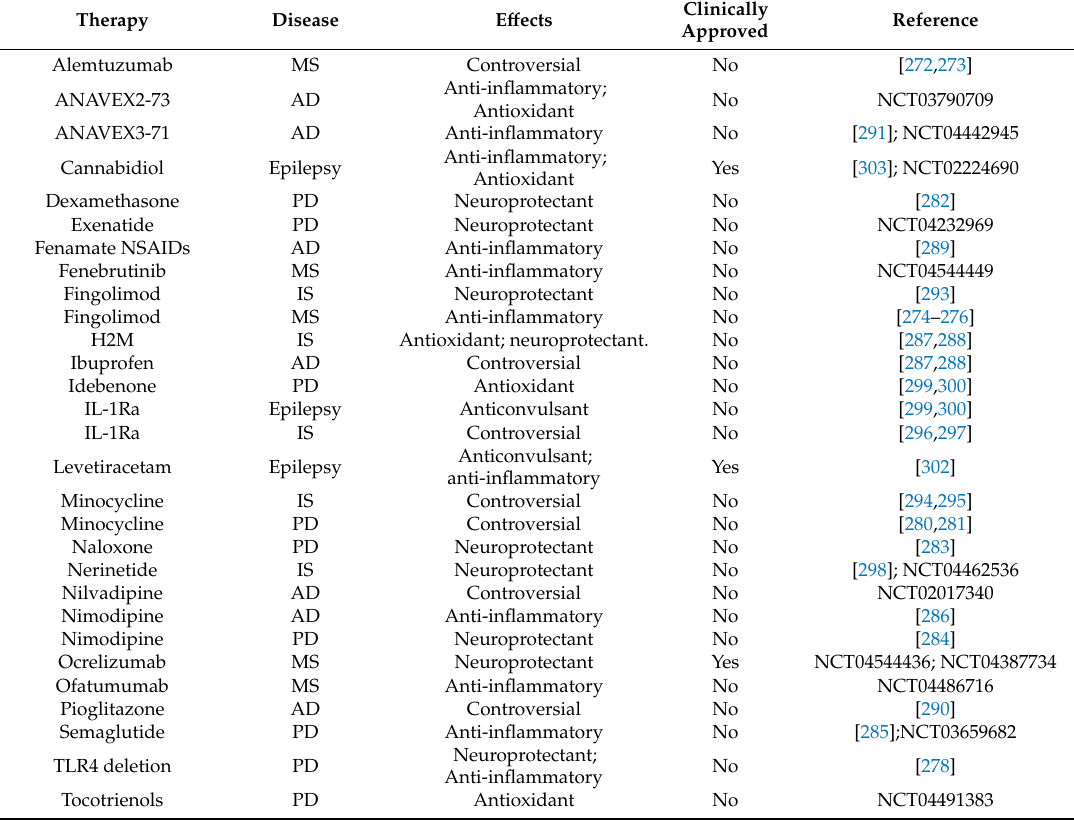
Table 1. List of recent studies and drug therapies targeting neuroinflammation in Parkinson’s disease, Alzheimer’s disease, multiple sclerosis, ischemic stroke, and epilepsy. The clinically approved column refers to the approval of the drug for the treatment of the specific CNS disease. Refer to the text for the explanation of controversial e ff